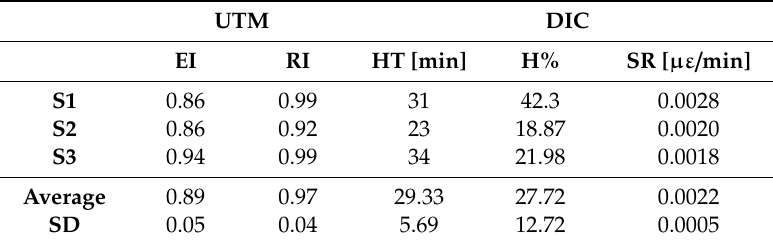
Table 3. Healing parameters of three identical asphalt samples using the data acquired by the UTM and DIC. UTM DIC EI RI HT [min] H% SR [ µε / min] S1 0.86